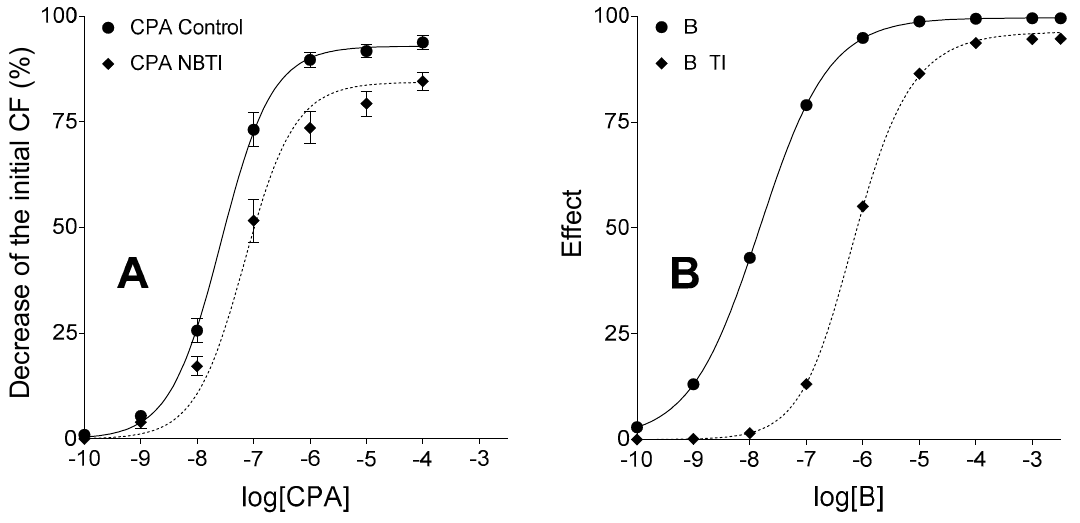
Figure 3. Ex vivo biological (panel A ) and in silico simulated (panel B ) models exhibiting E/c curves of a synthetic agonist with a long half-life, in the absence and presence of an agonist transport inhibitor, acting in a system with naïve receptor population. The transport inhibition do not affect the fate of the agonist used for the E/c curves, only the transport of the endogenous agonist (activating the same receptor as the synthetic one) was inhibited in both models. The x -axis indicates the common logarithm of the molar concentration of agonists (in the bathing medium), and the y -axis denotes the effect. The continuous lines represent the fitted Hill equation, while the dotted lines show the fitted equation of RRM (receptorial responsiveness method). On the panel A , symbols show the mean ± SEM. CPA: N 6 -cyclopentyladenosine; NBTI: a treatment with S-(2-hydroxy-5-nitrobenzyl)-6-thioinosine; B: agonist B (simulating CPA); TI: a treatment with an inhibitor of the transport of agonist A but not B (simulating the presence of NBTI); CF: contractile force. Data of panel A are redrawn from [31].